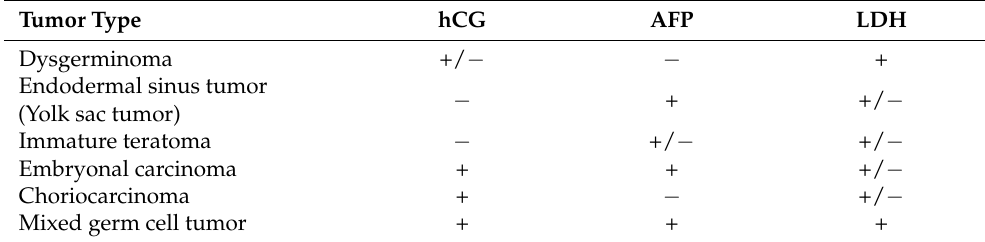
Table 4. Serum markers associated with